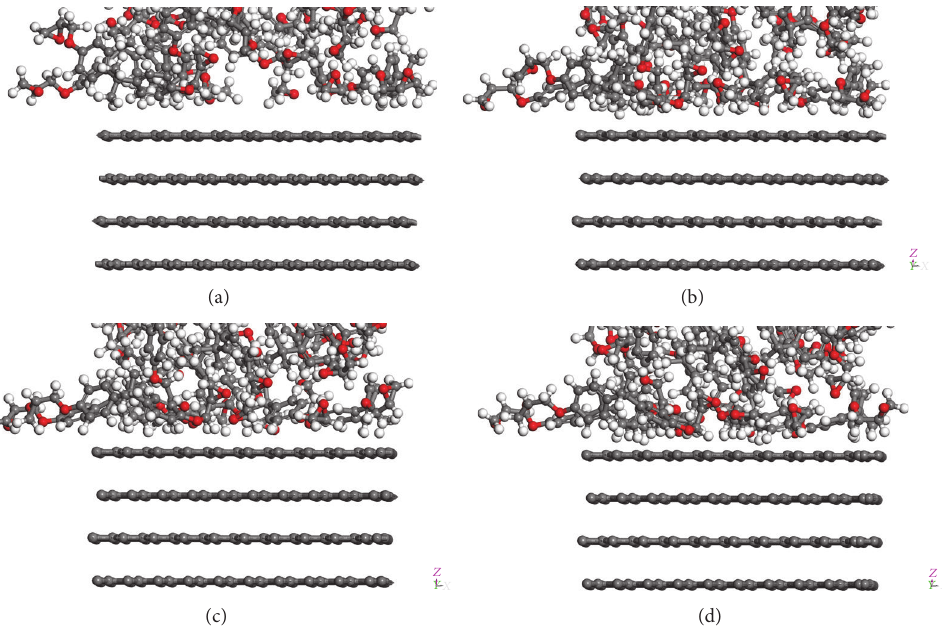
Figure 10: The adsorption process at the compaction force of 250 kPa, laying speed of 27 m/min, and preheating temperature of 333.15 K: (a) simulation time of 0ps; (b) simulation time of 10ps; (c) simulation time of 20ps; (d) simulation time of